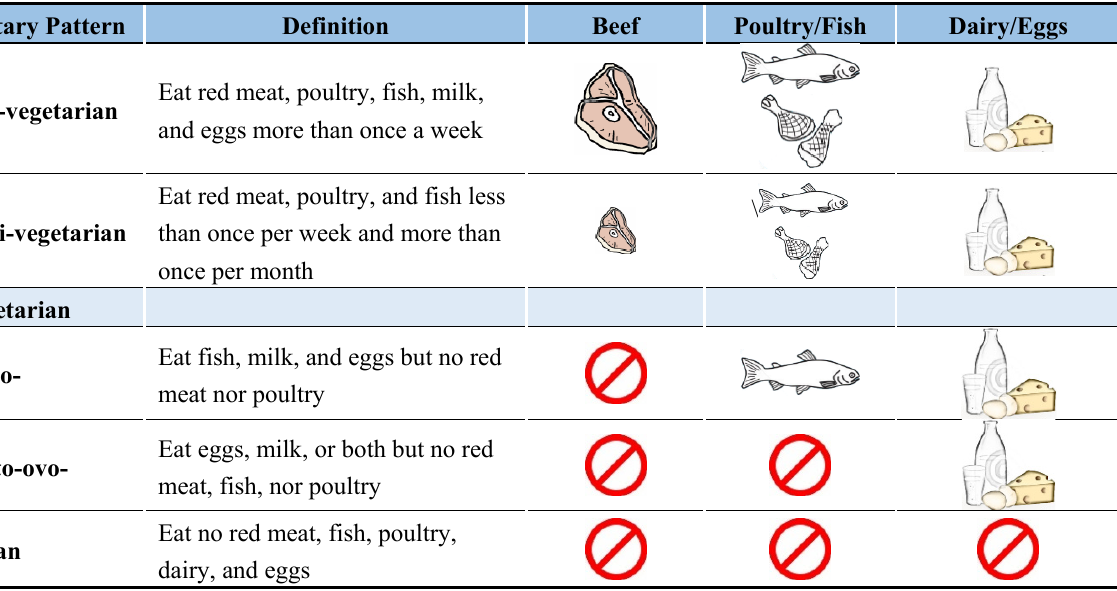
Table 1. Classification of dietary patterns